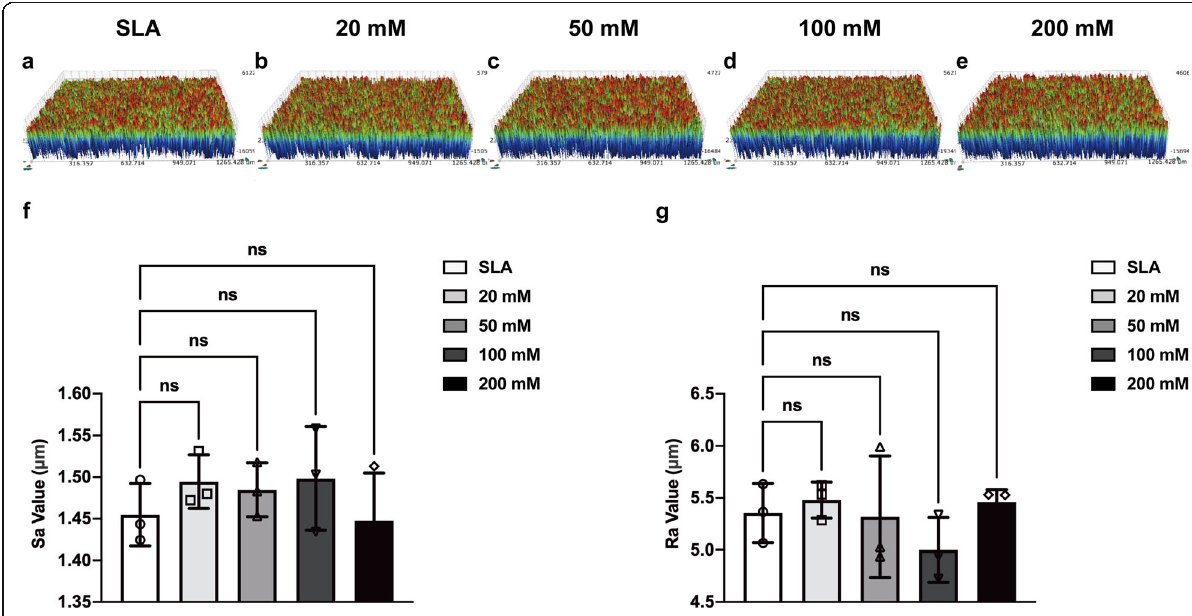
Fig. 2 Three-dimensional optical microscopy images of the surface morphology from SLA ( a ), 20 mM sodium bicarbonate@SLA ( b ), 50 mM sodium bicarbonate@SLA ( c ), 100 mM sodium bicarbonate@SLA ( d ), and 200 mM sodium bicarbonate@SLA discs ( e ). Quantitative measurement of the roughness of each group by the S a value ( f ) and the R a value ( g ). Data are presented as the mean ± standard deviation ( n = 3, * P < 0.05; ** P < 0.01; *** P <